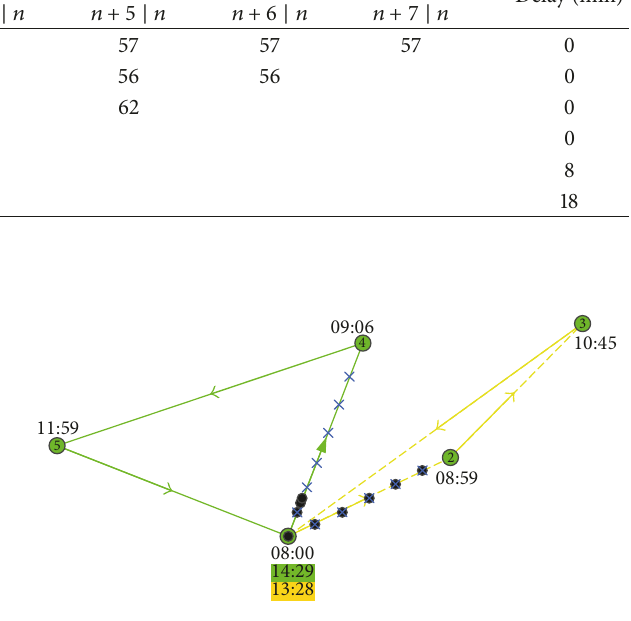
Table 2: Control of the average speed (km/h) and the expected delay (min) according to systems states update. Sample 𝑛